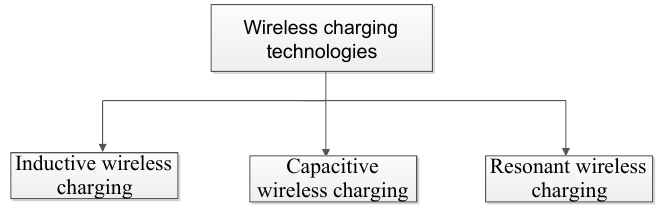
Figure 7. Taxonomy on wireless charging based on the